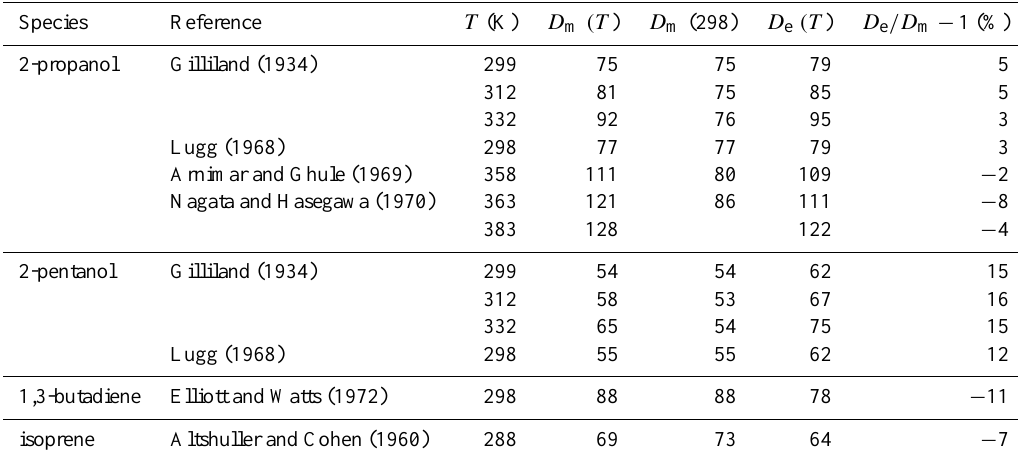
Table A2. Measured and estimated diffusivities of 2-propanol, 2-pentanol, 1,3-butadiene, and isoprene, and comparison with estimated values. The unit for diffusivities is Torrcm 2 s − 1